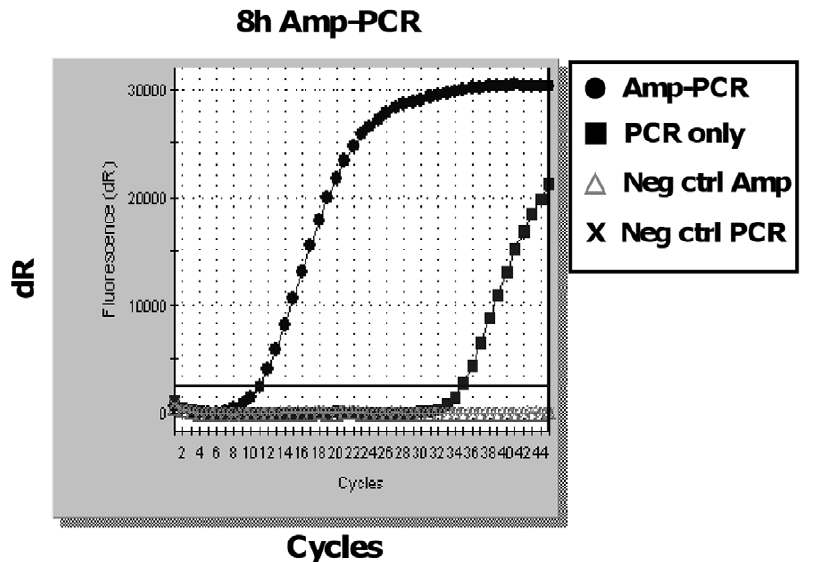
Figure 2. Amp-PCR on purified JCV from a clinical sample. Using purified viral JCV-DNA ( , 36 copies/ m l) from a clinical CSF sample, 8 hours of Amp-PCR was compared to PCR only. The D Ct-value =24 demonstrating that Amp-PCR gives a strong amplification of the JVC material before the specific PCR. Negative control for both amplification and PCR is water.